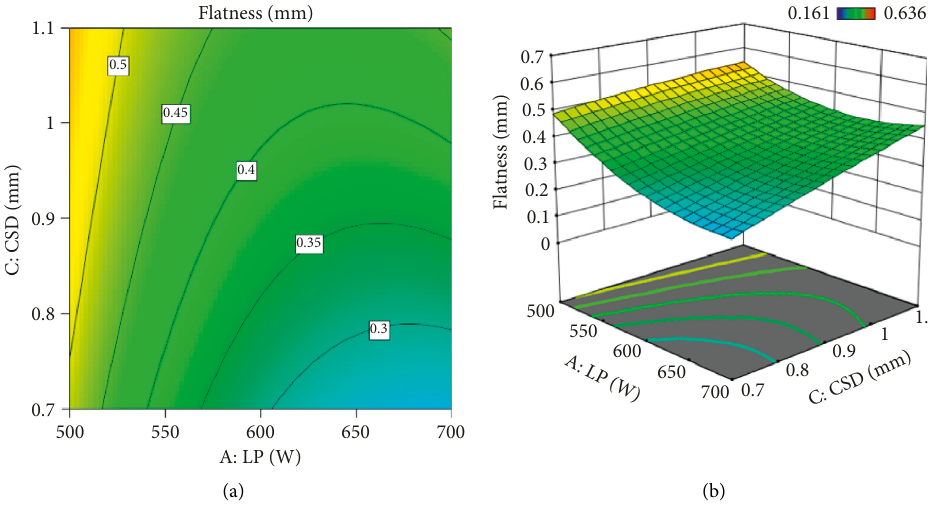
Figure 10: Influence of the interaction between the laser power and the cladding step on surface flatness: (a) contour map; (b) three- dimensional response